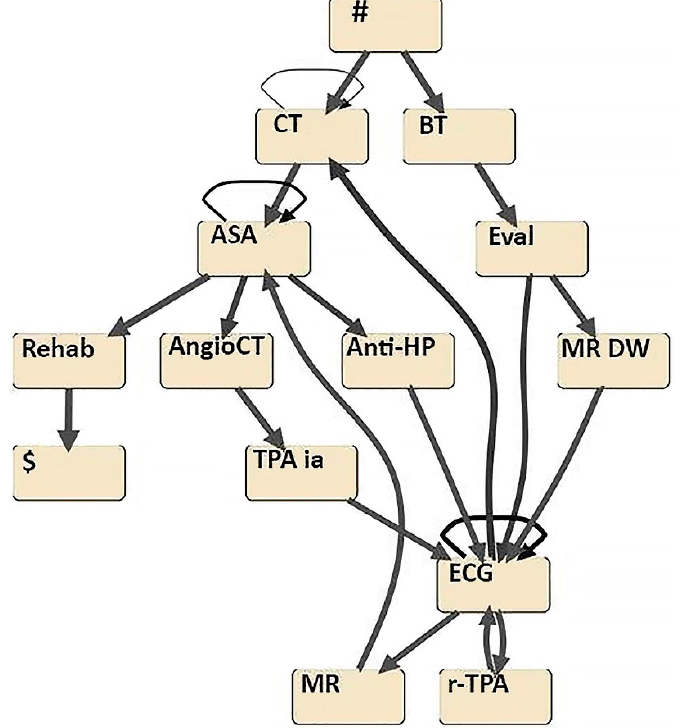
Figure A2. Process model generated by the Fuzzy plugin. The box containing the symbol “#” indicates the entry point of the model, while the “$” box represents the ending (final) action of the model.